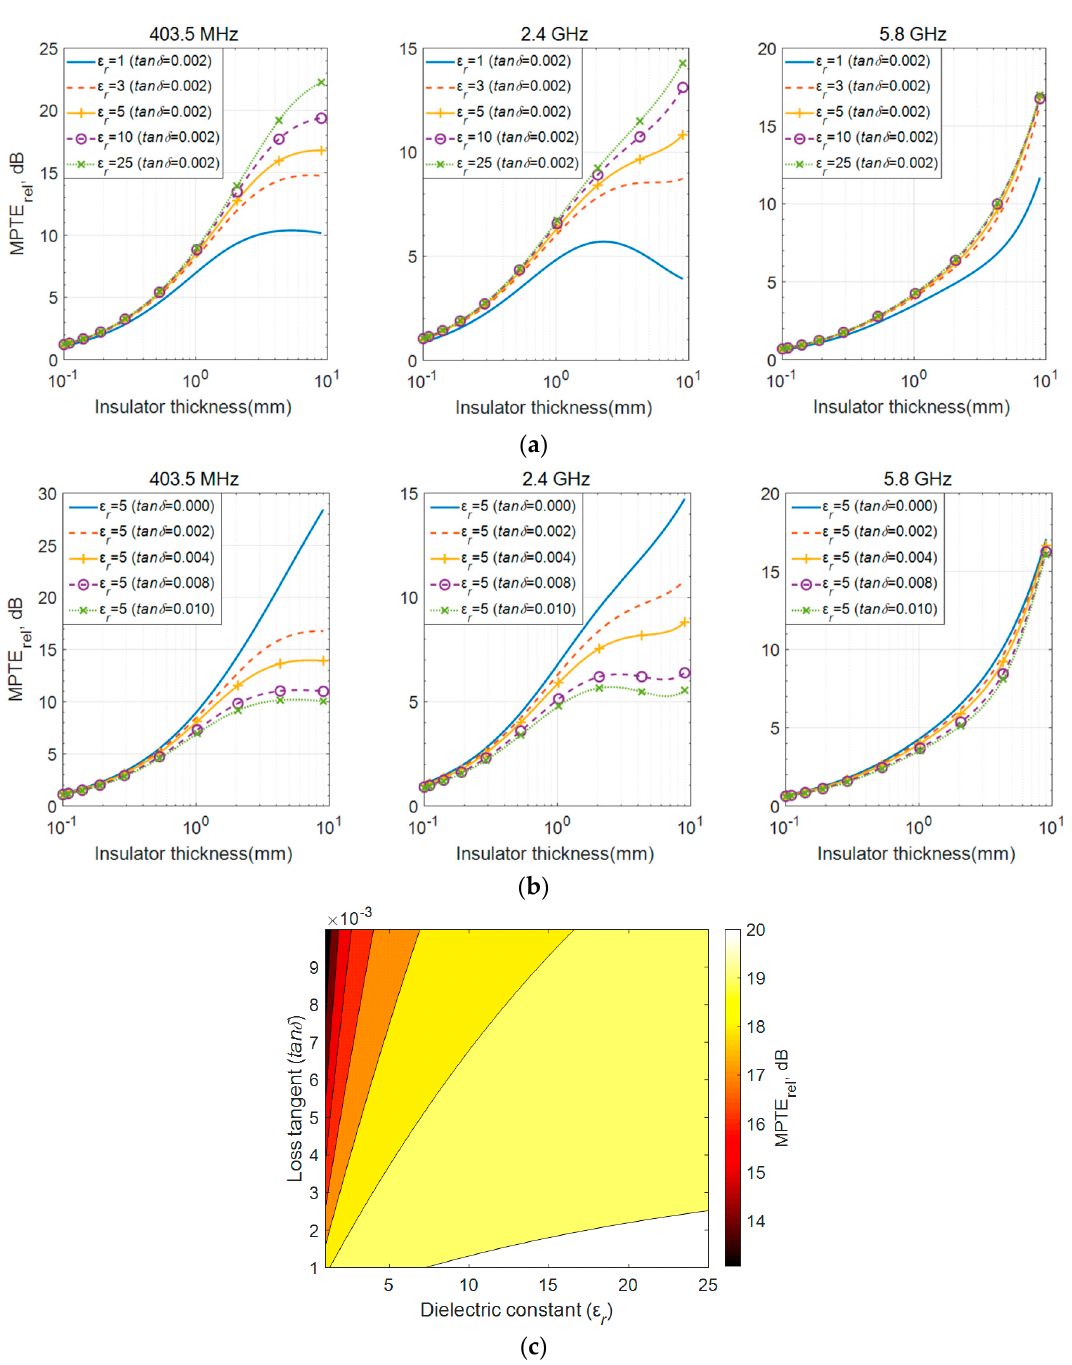
Figure 6. MPTE rel results according to dielectric properties: ( a ) varying dielectric constant with stable loss tangent; ( b ) varying loss tangent with stable dielectric constant; ( c ) variations in ε r and tan δ at 403.5 MHz.